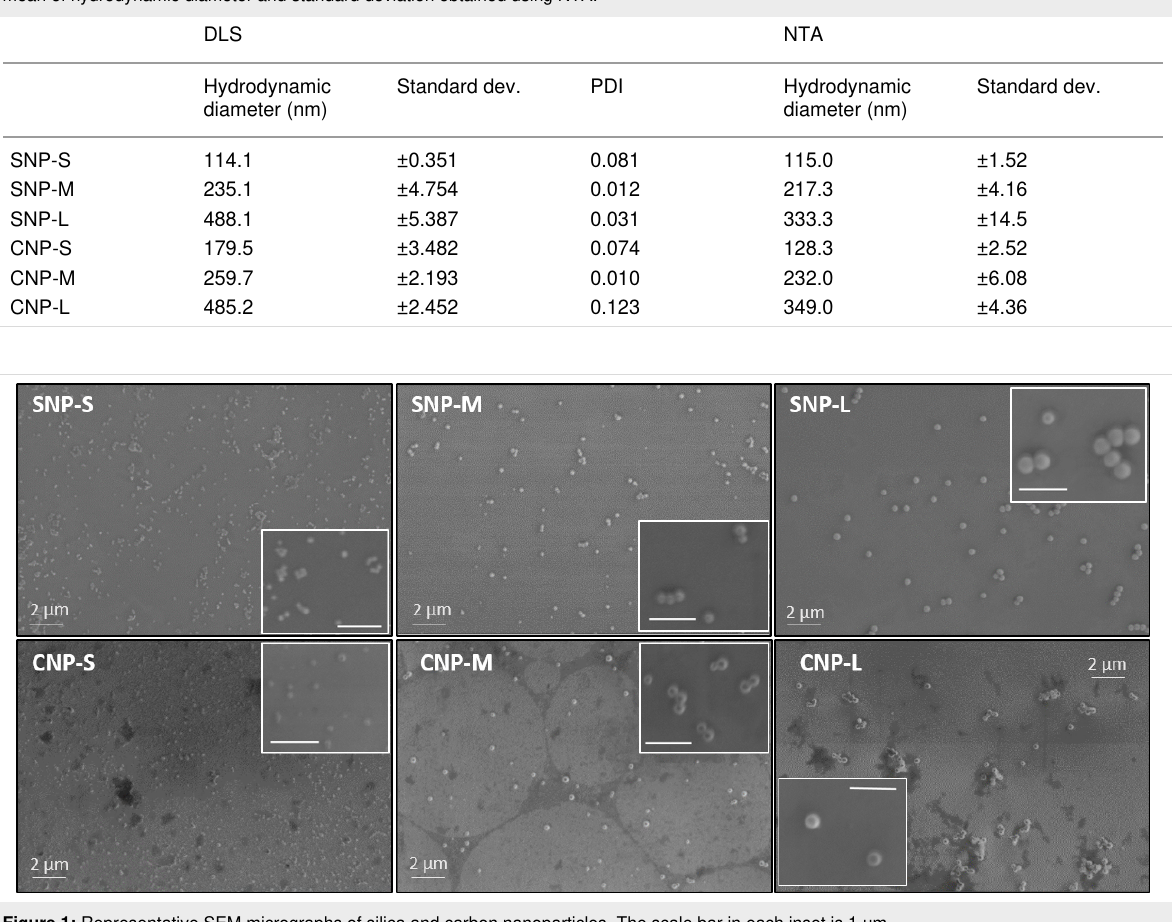
Figure 1: Representative SEM micrographs of silica and carbon nanoparticles. The scale bar in each inset is 1 μ